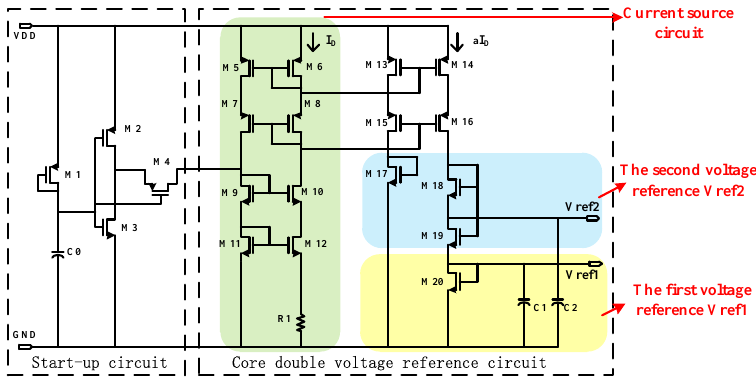
Figure 1. Proposed dual-output voltage reference circuit.